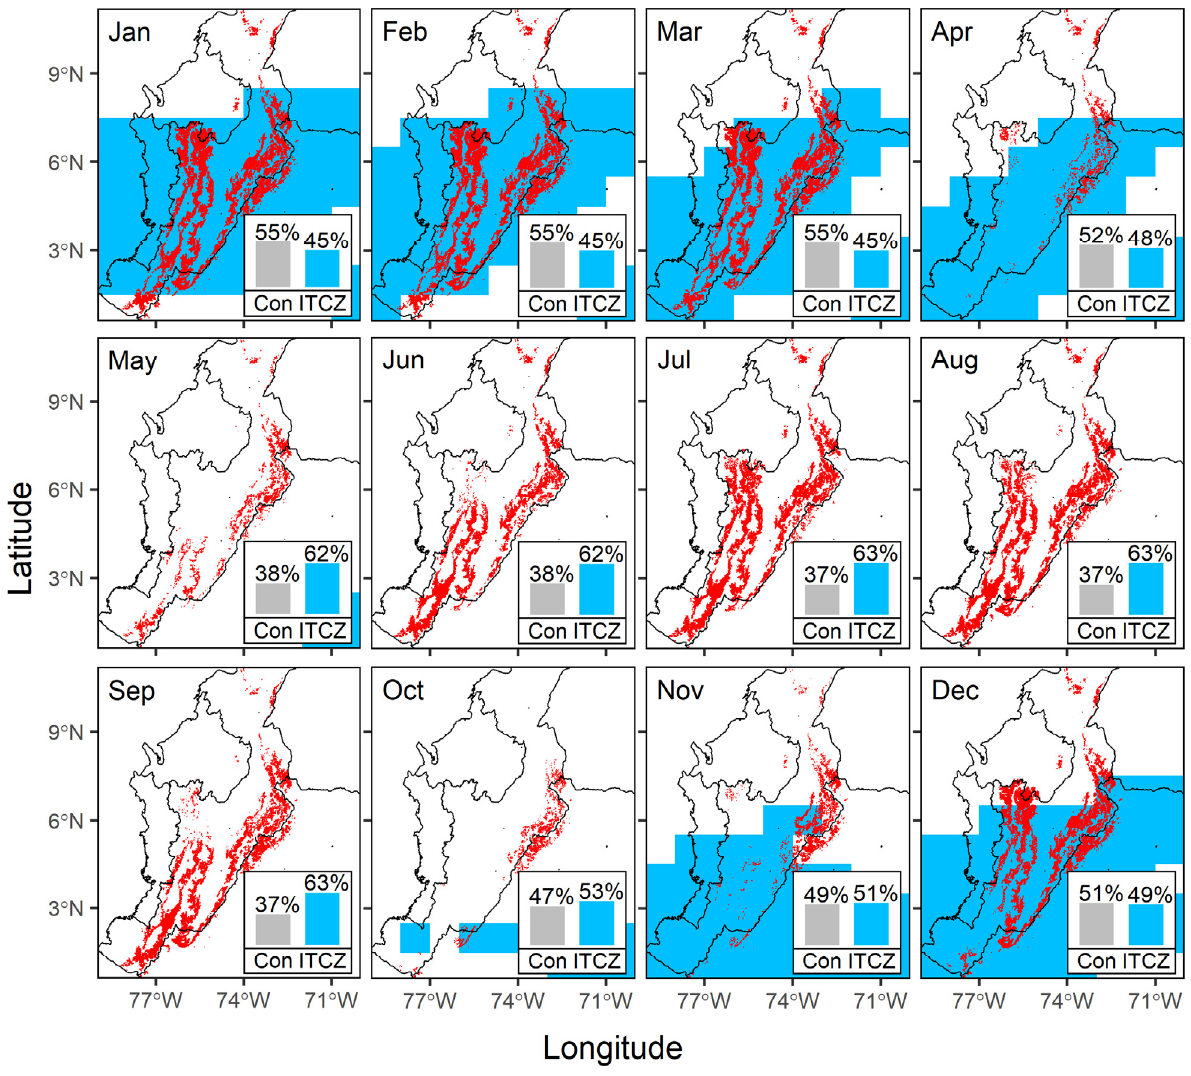
Figure 6. Spatiotemporal distribution of the area that requires irrigation in PPA and the relative percentual weight of ITCZ location (blue) on IR in comparison to a control variable (Con, gray) product of the relevance metric analysis.